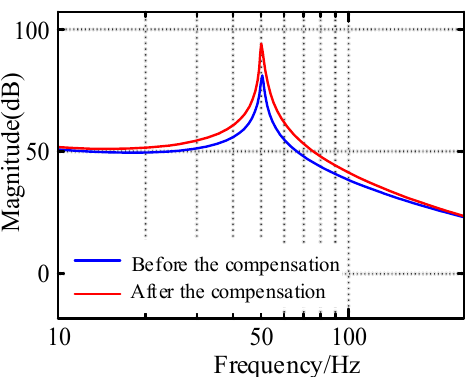
Figure 4. Control block diagram of optimized indirect current control with reference current com- pensation.